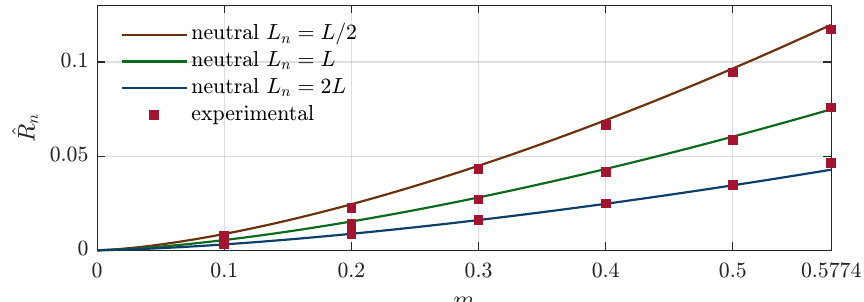
Figure 12. Experimental validation of normalized neutral-current-ripple RMS for L n = L /2, L n = L , and L n = 2 L (i.e., g = 0.5, g = 1, and g = 2). Normalization base V dc / ( 2 Lf sw )